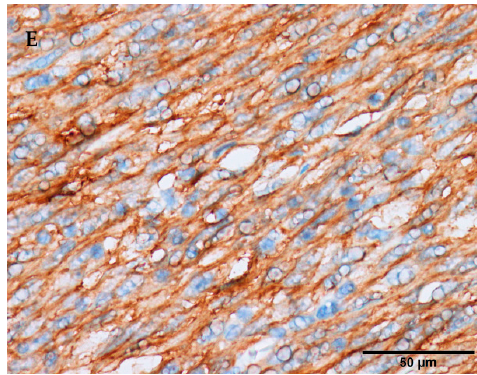
Figure 1. Histomorphology and immunohistochemistry in GISTs (own images, the scale bar is 50 µ m). ( A ) Spindle cell type is mainly composed of fusiform cells with a spiral or palisading arrangement (H&E stain, × 400). ( B ) Epithelioid cell type is mainly composed of cords or small nests of epithelioid cells (H&E stain, × 400). ( C ) Mixed, spindle-epithelioid type is composed of spindly and epithelioid cells with a staggered arrangement (H&E stain, × 400). ( D ) Tumor cells are strongly positive for CD117 (EnVision stain, × 400). ( E ) Tumor cells are positive for DOG-1 (EnVision stain, × 400).